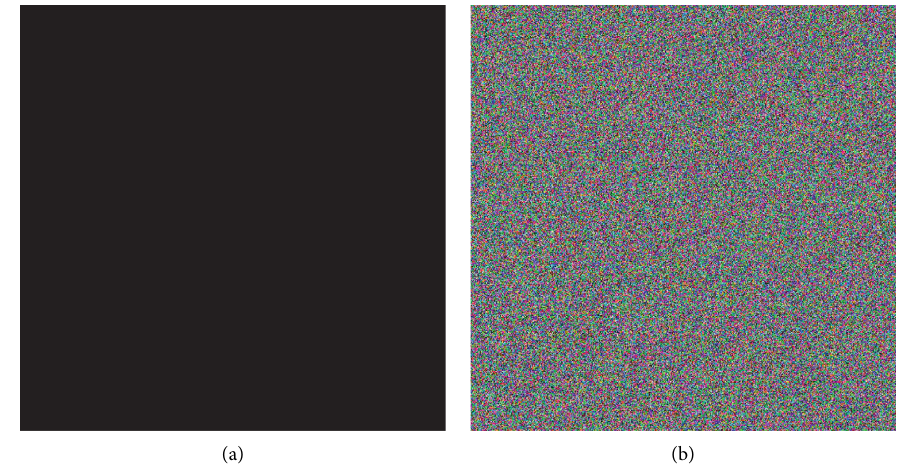
Figure 3: Zero plaintextimage P